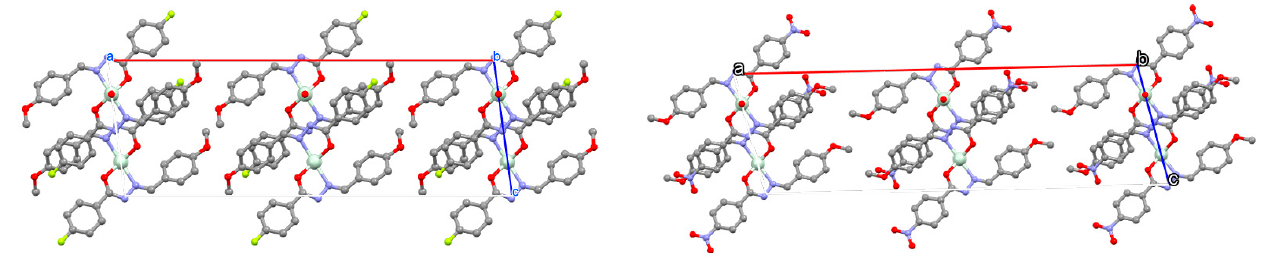
Figure 5. Thermal ellipsoids representation of Ac1 (on the left ) and Ac2 (on the right ) drawn at 50% Figure 6. Crystal packing of Ac1 (on the left ) and Ac2 (on the right ) showing the assembly of te- probability Ortep representation. Atoms are color-coded as follows: carbon (brown), hydrogen tramers along the b-axis (water molecule indicated as a red sphere). For sake of clarity, only the Ac2 (white), oxygen (red), nitrogen (blue), zinc (light gray), fluorine (yellow). adduct with higher occupancy is shown. Atoms are color-coded as follows: carbon (brown), hydro- gen (white), oxygen (red), nitrogen (blue), zinc (light gray), fluorine (yellow).